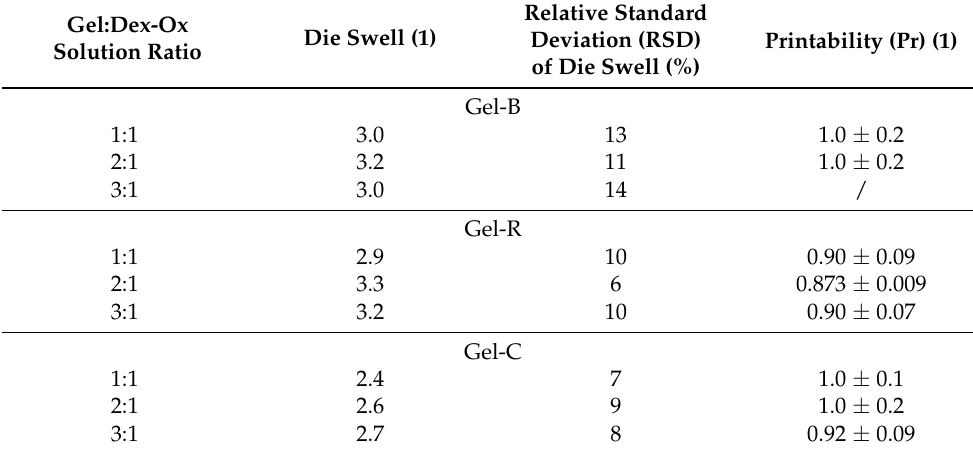
Table 2. Printing characteristics of Gel-based